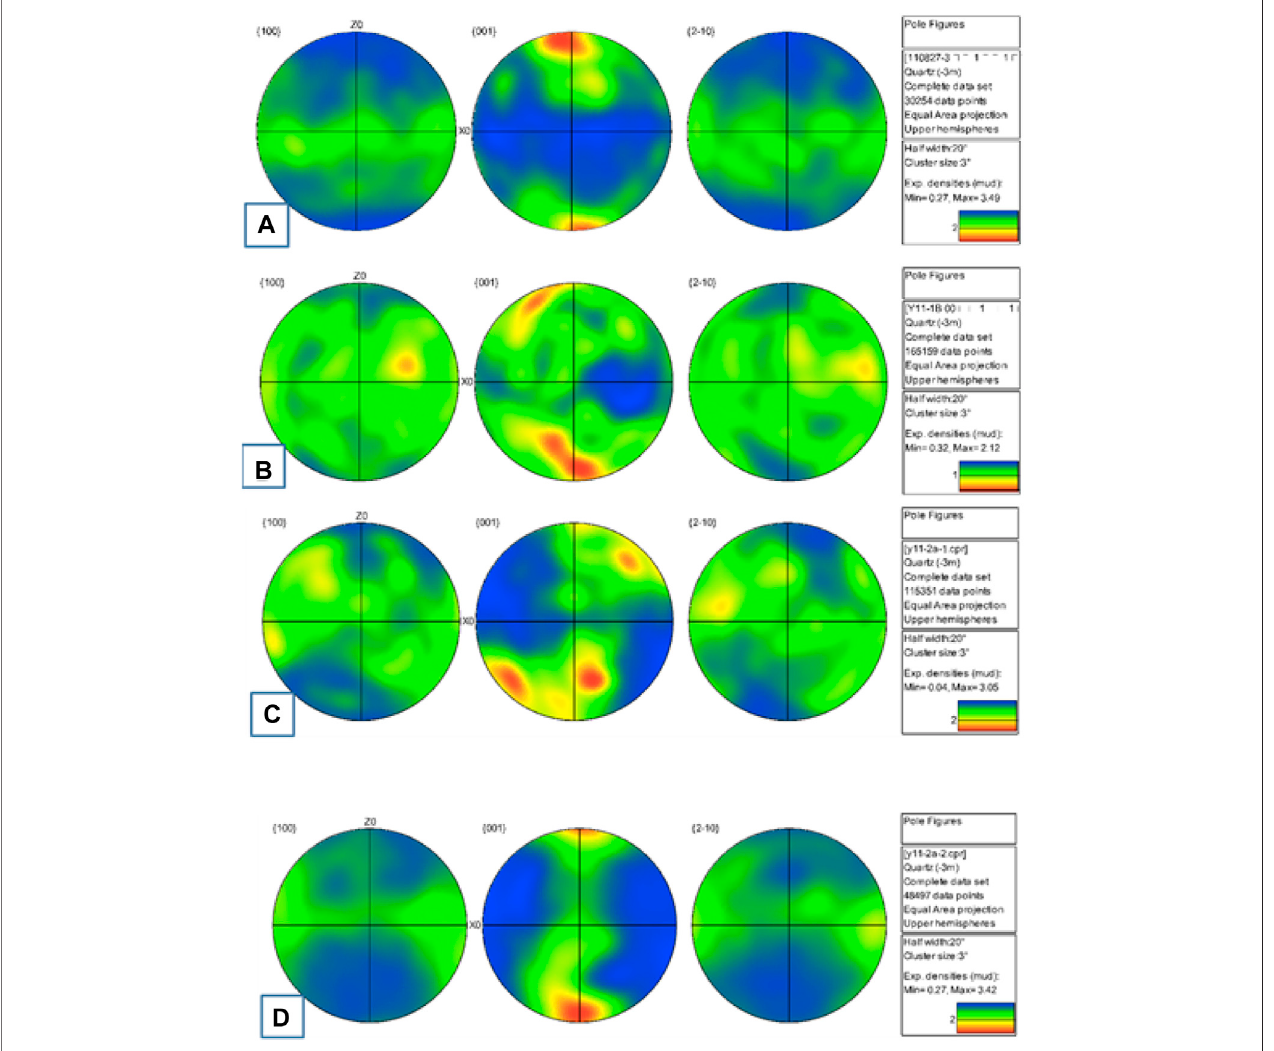
FIGURE 6 | Quartz fabric from EBSD in samples of pseudotachylyte and cataclasite. (A) Thin section of 110827-3, (B) thin section of Y11-1B, (C) thin section of Y11-2A-1, (D) and thin section of Y11-2A-2 (All sections were cut perpendicular to the XY plane of the mylonites, and different numbers − 1 or − 2 in a same sample was parallel or perpendicular to the X